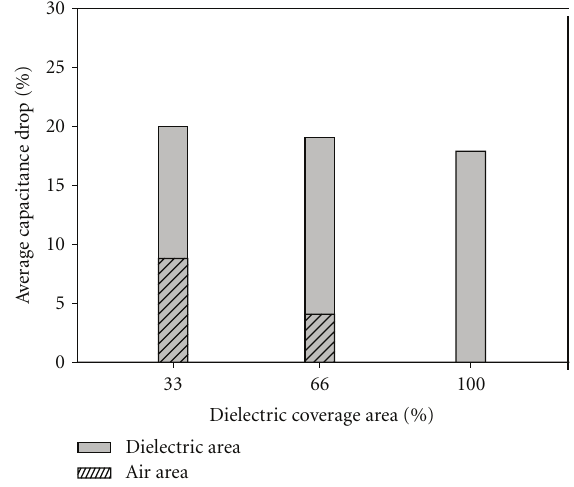
Figure 16: Average capacitance drop for dielectric coverage area.